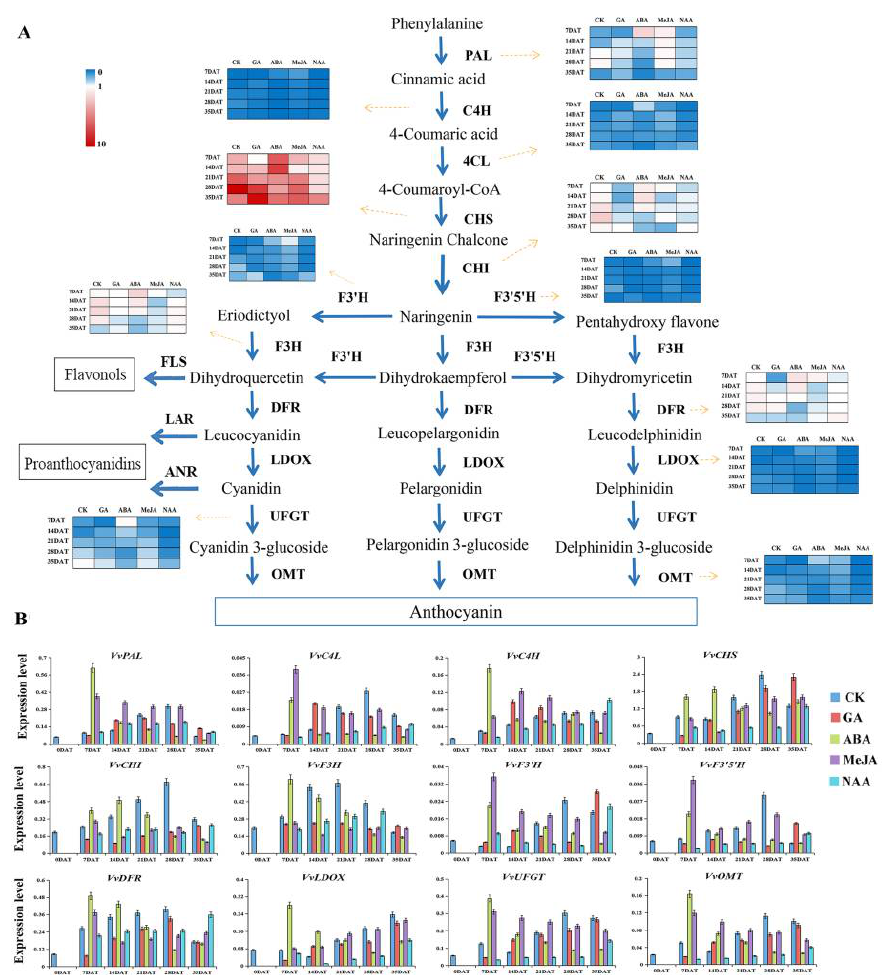
Figure 7. Expression modes of genes related to anthocyanin synthesis by different hormone treat- ments. ( A ) Anthocyanin metabolism pathway. ( B ) The expression of anthocyanin-related genes by different hormone treatments.